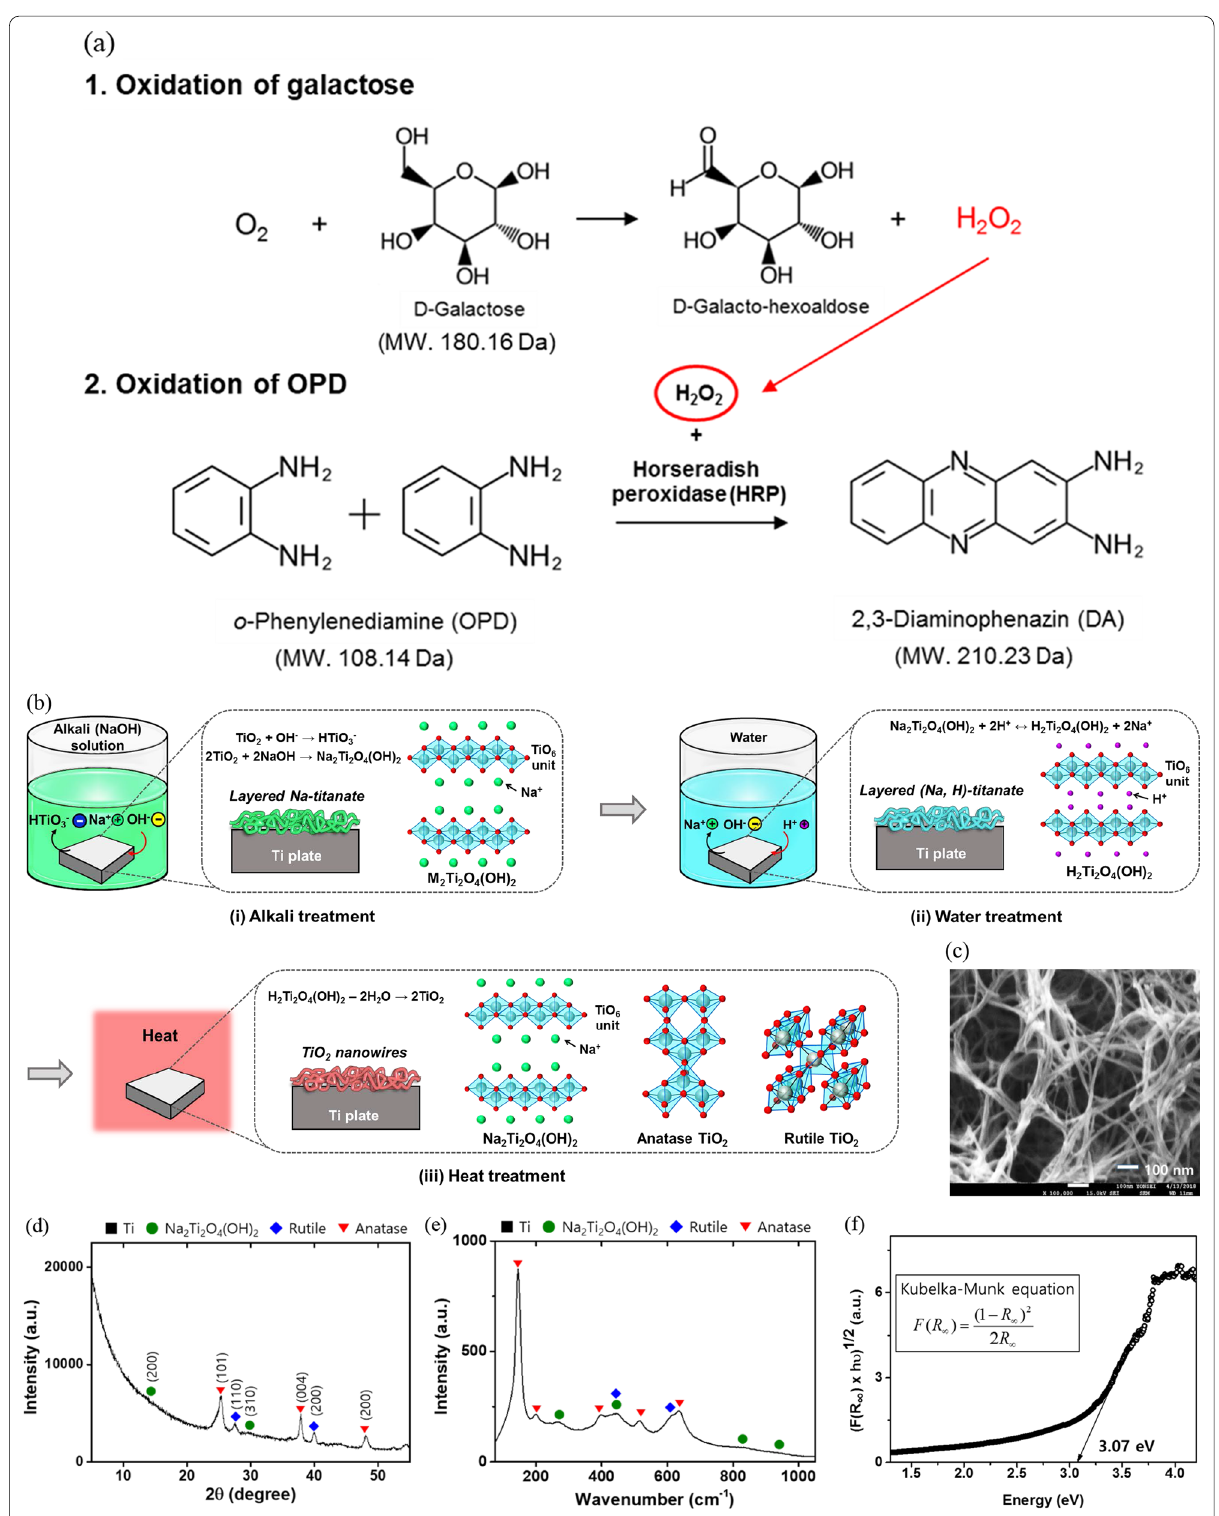
Fig. 1 Galactose analysis based on the reaction of o ‑phenylene diamine (OPD). a Diagram representing the reactions in the assay for galactose using OPD as a substrate. b Preparation of the TiO 2 nanowire chip. c FE‑SEM image of the TiO 2 nanowire chip. d XRD pattern of the TiO 2 nanowire. e Raman spectrum of the TiO 2 nanowire. f Diffuse reflectance UV–vis spectra and Tauc plot of (F(R spectra of galactose, OPD, and DA using MALDI‑TOF MS based on conventional organic matrices (CHCA, DHB) and the TiO 2 nanowire